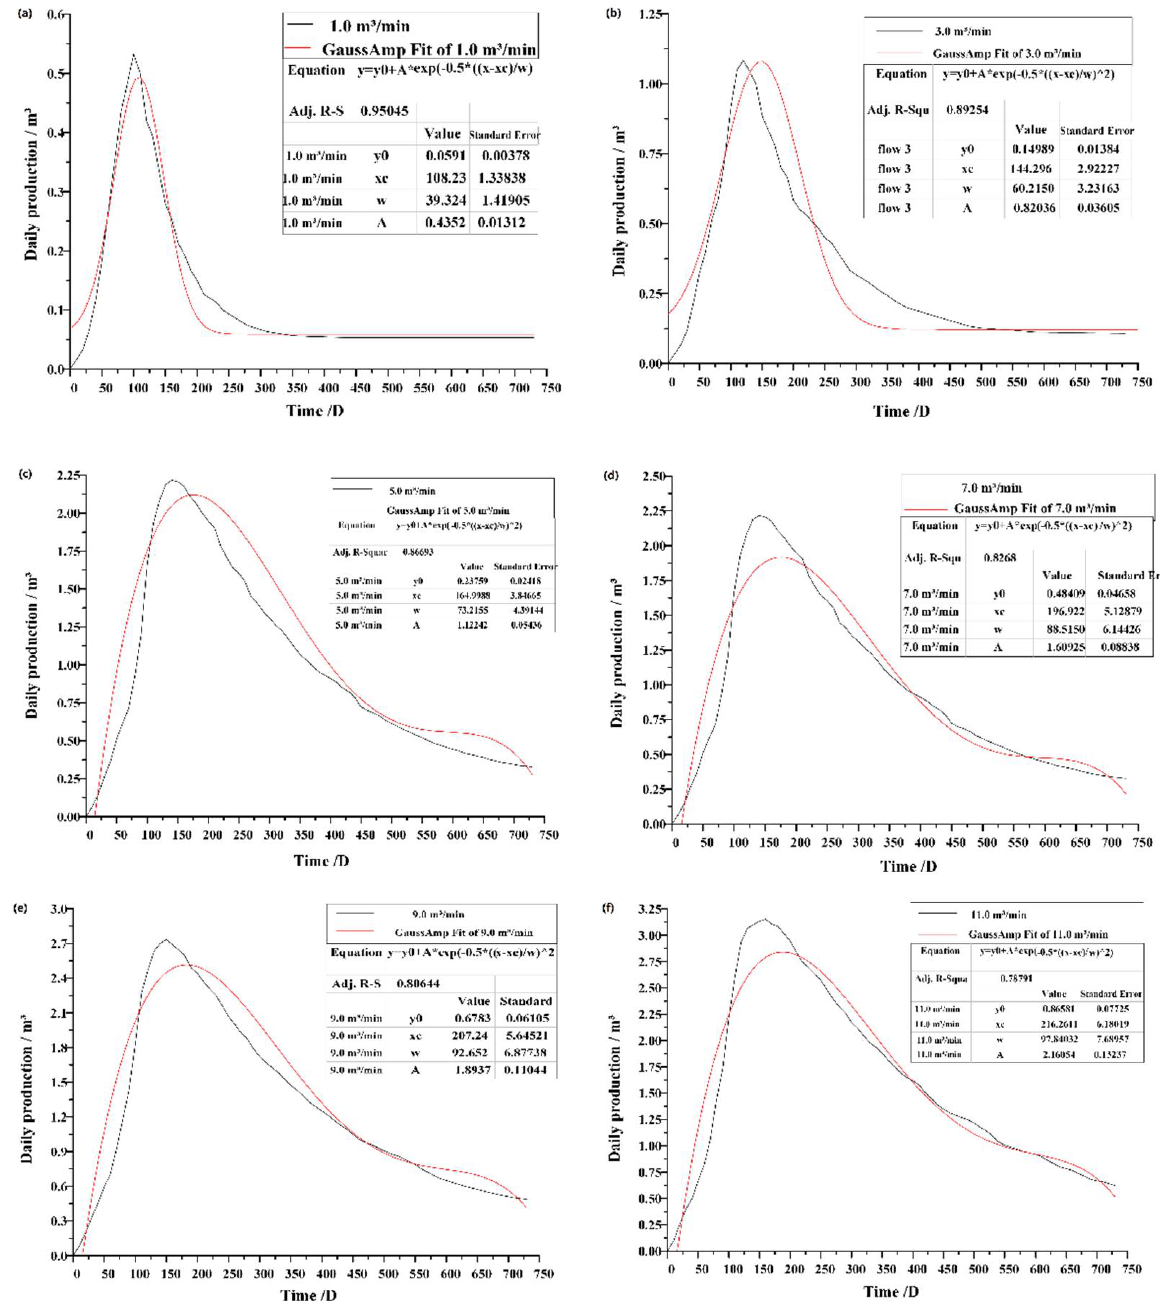
Figure 6. Variation curve of daily output of the mining well under different flow rates. ( a ) 1.0 m 3 /min ( b ) 3.0 m 3 /min ( c ) 5.0 m 3 /min ( d ) 7.0 m 3 /min ( e ) 9.0 m 3 /min ( f ) 11.0 m 3